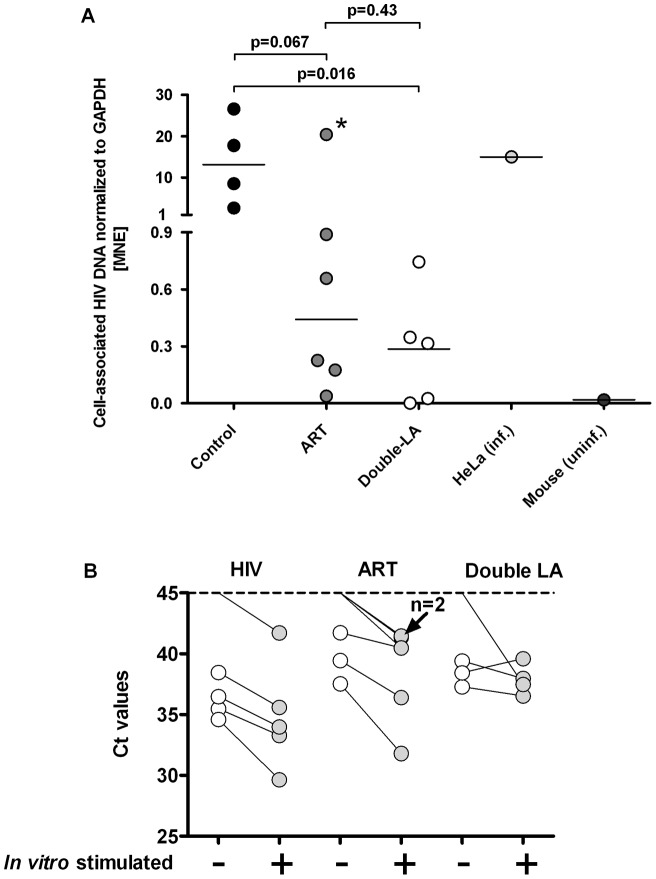
Recovery of cell-associated HIV DNA (A) and increase of HIV mRNA transcripts in vitro from splenic tissue obtained from HIV-infected mice with suppressed HIV RNA following activation.(A) DNA from infected HeLa cells (HeLa inf) and from the spleen of HIV-infected mice served as positive controls, DNA from an uninfected humanized mouse (uninf) served as negative control. The specimens of the treated and HIV-infected mice were from the experiments investigating the antiviral potency of the double long-acting drugs; (MNE = mean normalized expression). B) Splenic tissue specimens from either HIV infected ART naïve hu mice (HIV), ART treated mice (ART) or mice treated with the two long acting drugs (Double-LA) were subjected to mitogens (PMA, PHA) in concert with anti-CD3/28 and IL-7. 18 hours later RNA was extracted and real-time PCR done for quantifying HIV Gag transcripts. Specimens of two mice which were treated with double LA drugs did not show any HIV transcript at all (data not shown in the graph); in five mice we did not detect any HIV transcripts prior to stimulation. The real-time PCRs were done in duplicates. *this specimen is from a mouse (#417) with detectable HIV RNA at the time of euthanization (see Table 2).